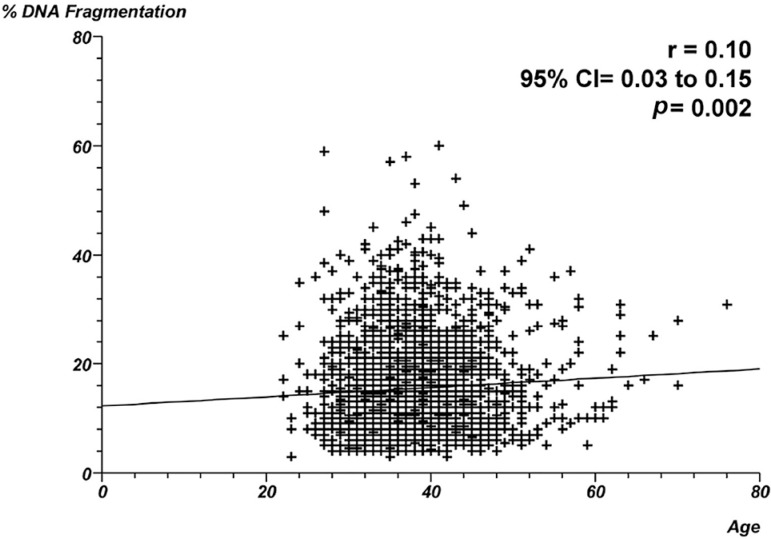
Correlation between male age and proportion of DNA fragmentation.
Individual data points and the regression line are shown. Spearman's
rank correlation coefficient = 0.10; p=0.002.